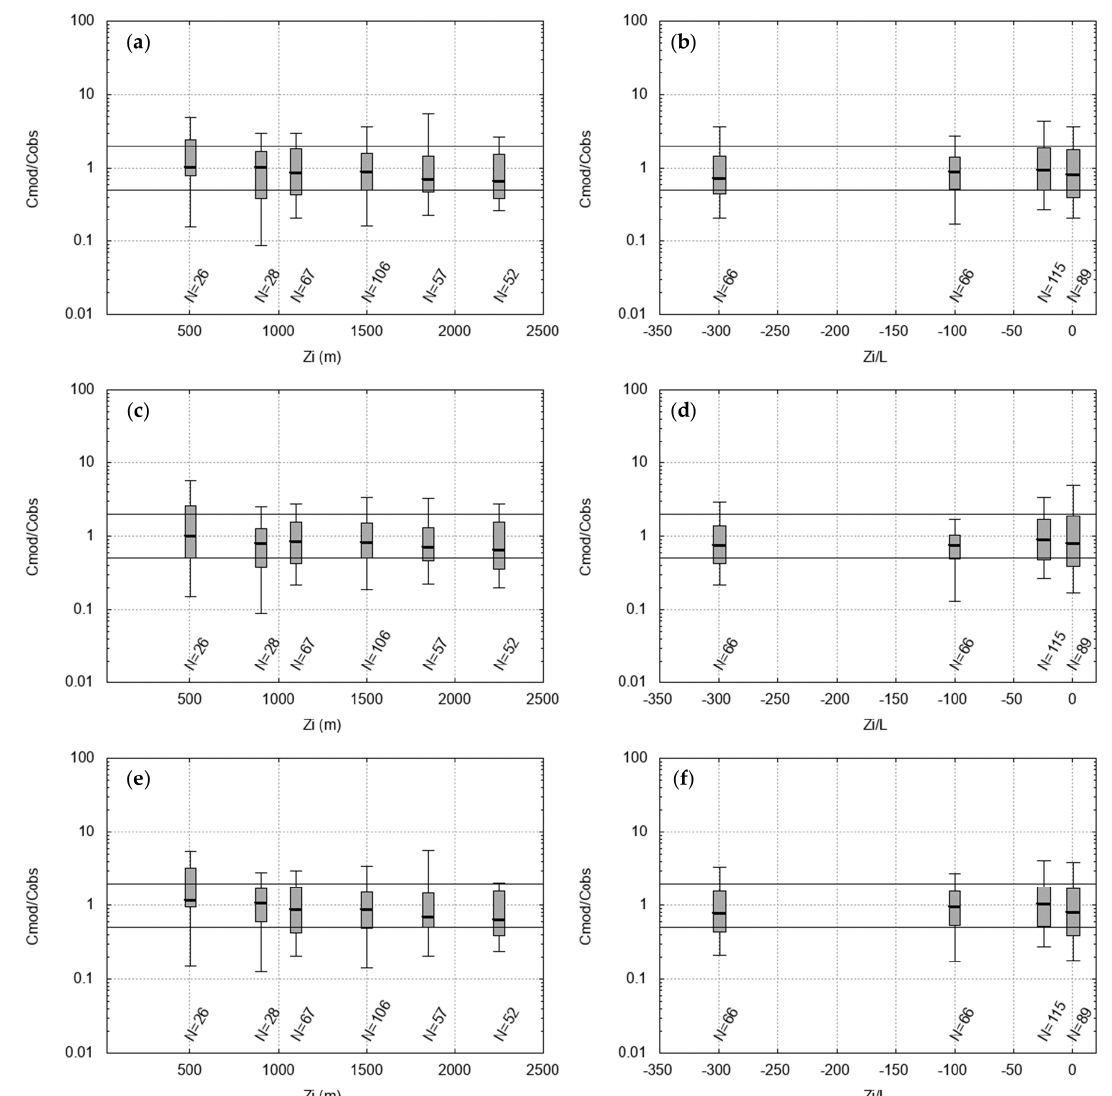
Figure 7. Residual box plots with respect to mixing height and ratio between mixing height and Monin Obukhov length for Kincaid SF 6 best-quality data: ( a ) WT plume rise, mixing height; ( b ) WT plume rise, ratio between mixing height and Monin Obukhov length; ( c ) JJ + RS plume rise, mixing height; ( d ) JJ + RS plume rise, ratio between mixing height and Monin Obukhov length; ( e ) JJ + JJ plume rise, mixing height; ( f ) JJ + JJ plume rise, ratio between mixing height and Monin Obukhov length.